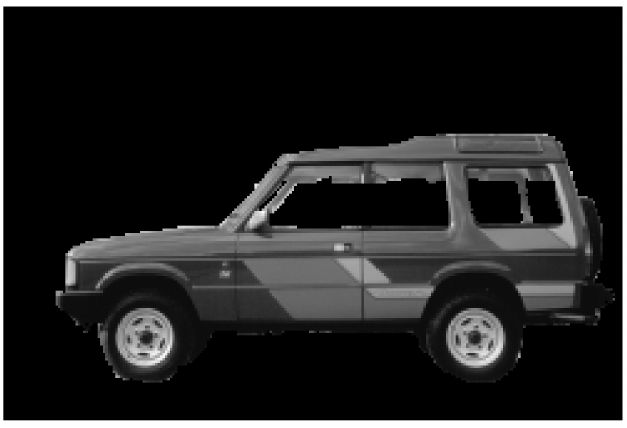
Figure 4. An Image